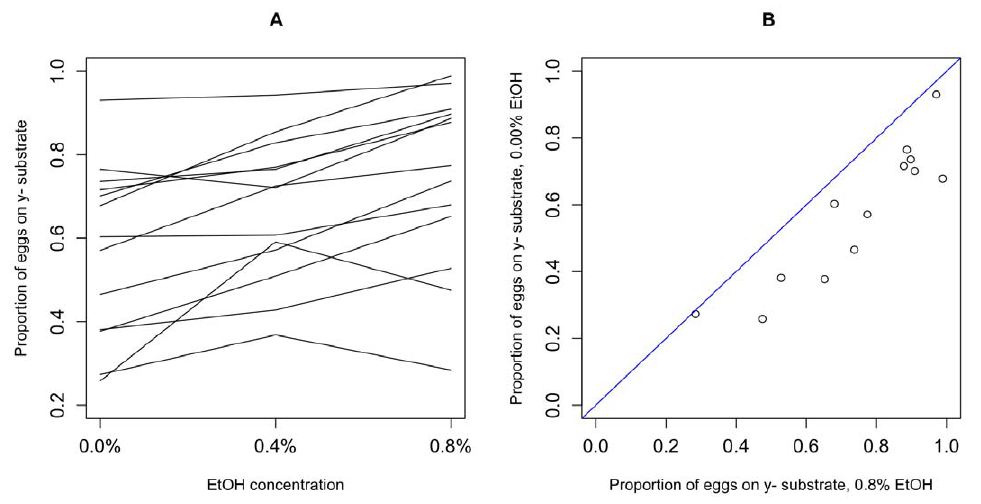
Figure 7. The effect of ethanol on oviposition preference. A: The effect of ethanol on behavior towards yeast is shown for 13 RAL genotypes at three concentrations of ethanol, where each line is a genotype. B: Plot of mean preference of genotypes in A, at two ethanol concentrations, shows that preferences are highly correlated between ethanol concentrations, with more avoidance of yeast substrate at higher ethanol concentration.